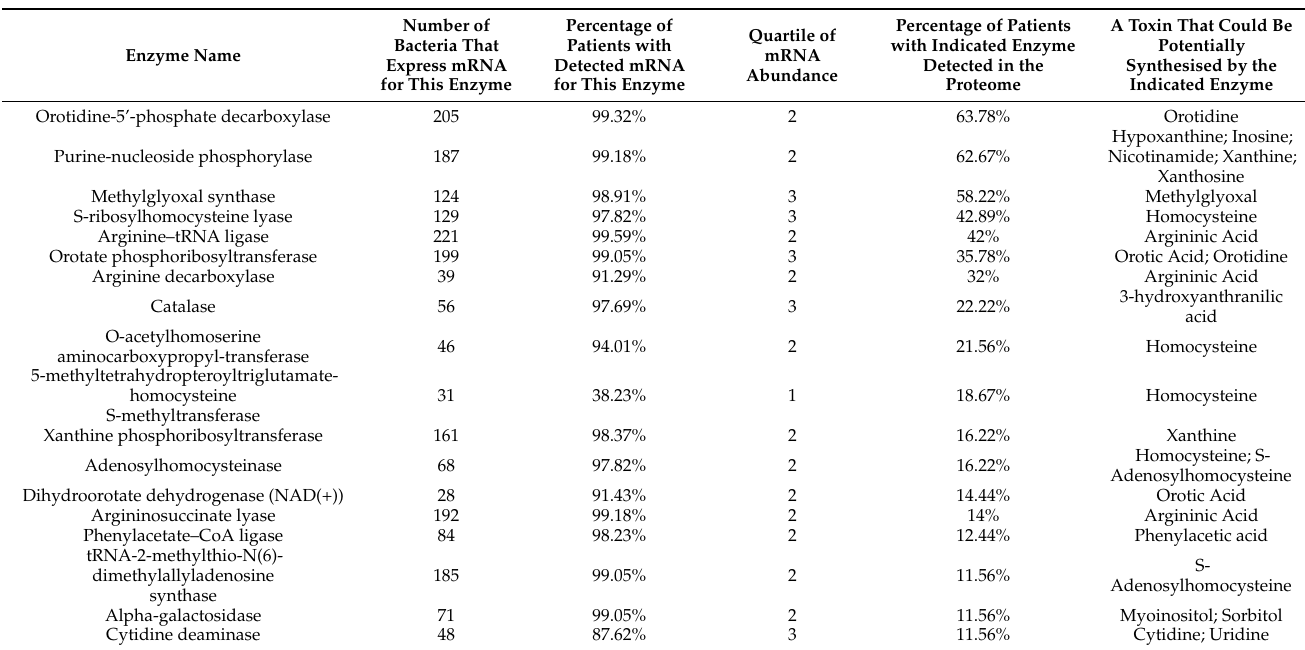
Table 4. Occurrence and abundance of uremic-retention-solutes-synthesizing enzymes in patients. Presented enzymes were detected in more than 10% of patients. The full list is available in Supple- mentary Table